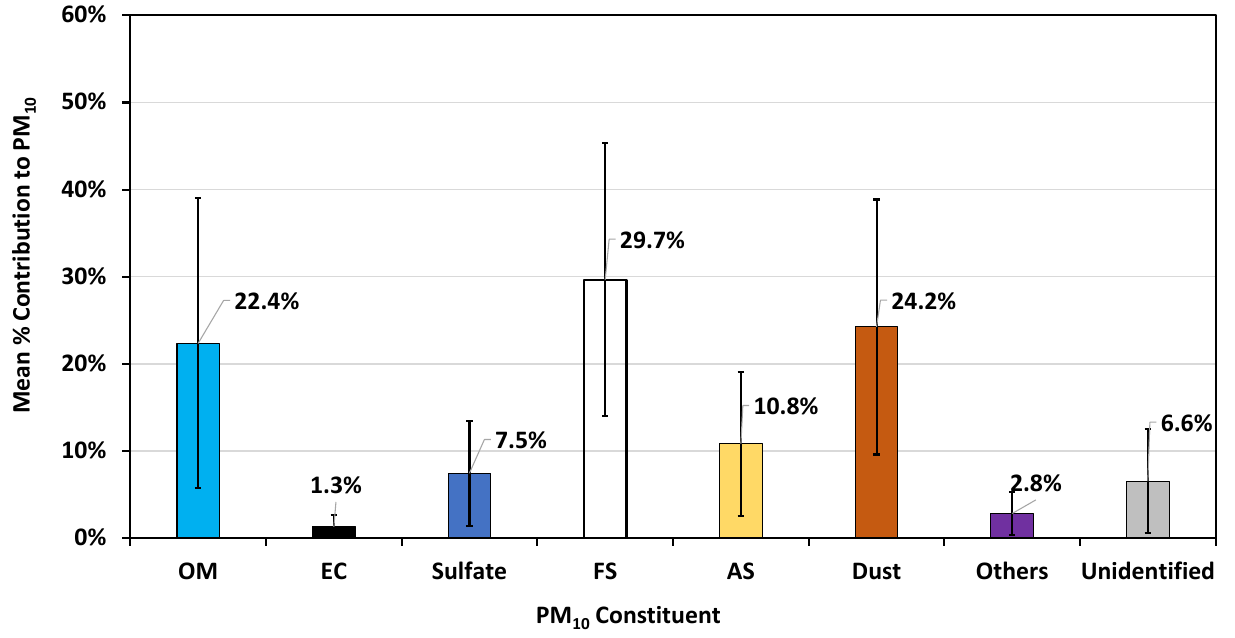
Figure 13. The mean source attribution of PM 10 , representing the non-exceedance days between April and October 2021. Error bars represent the standard deviations of the means based on 39 sam- ple days.